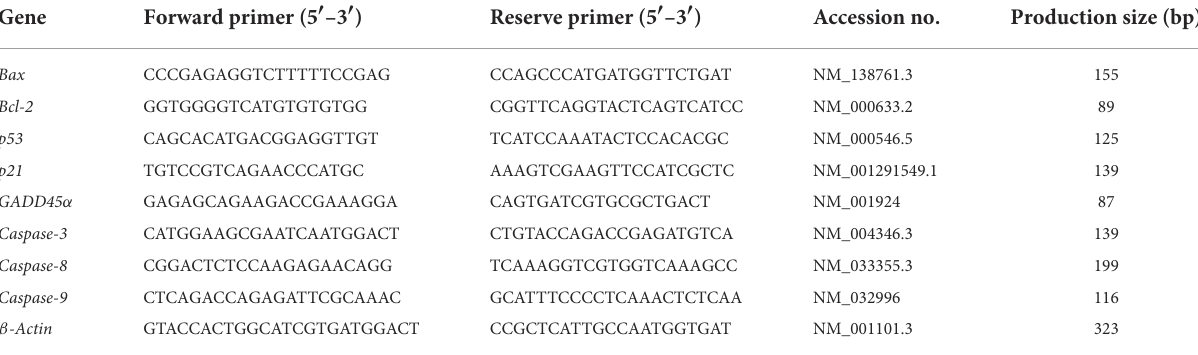
TABLE 1 Primers for qRT-PCR of cell apoptosis regulatory genes.